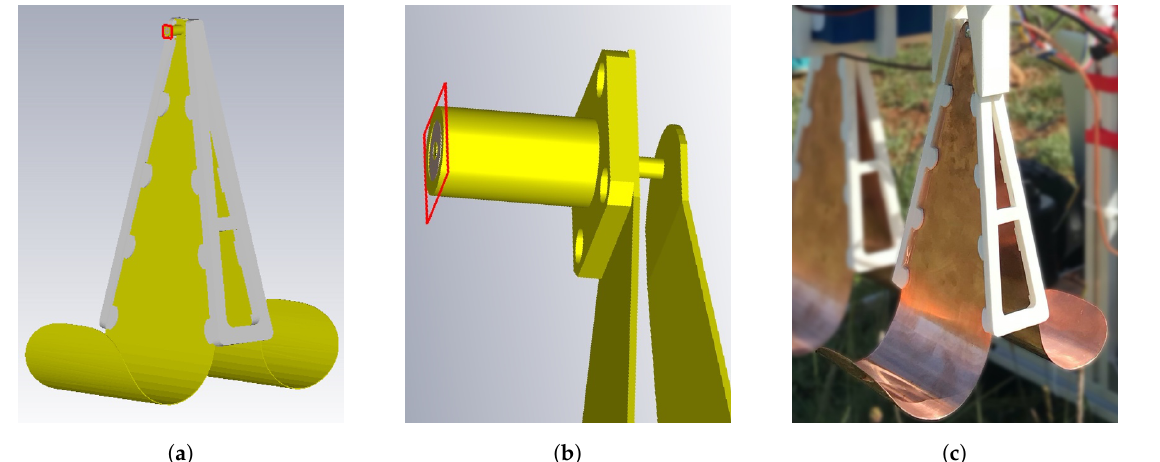
Figure 4. ( a ) Vivaldi–Horn (VH) antenna and a form holder (PLA polymer material with permittivity ε PLA = 1.8 at 1.5 GHz [27]) simulation model, which design is based on dimensions shown in Figure 3; ( b ) close up view of the antenna feed point (solid red line); ( c ) developed VH antenna with a 3D printed form holder.